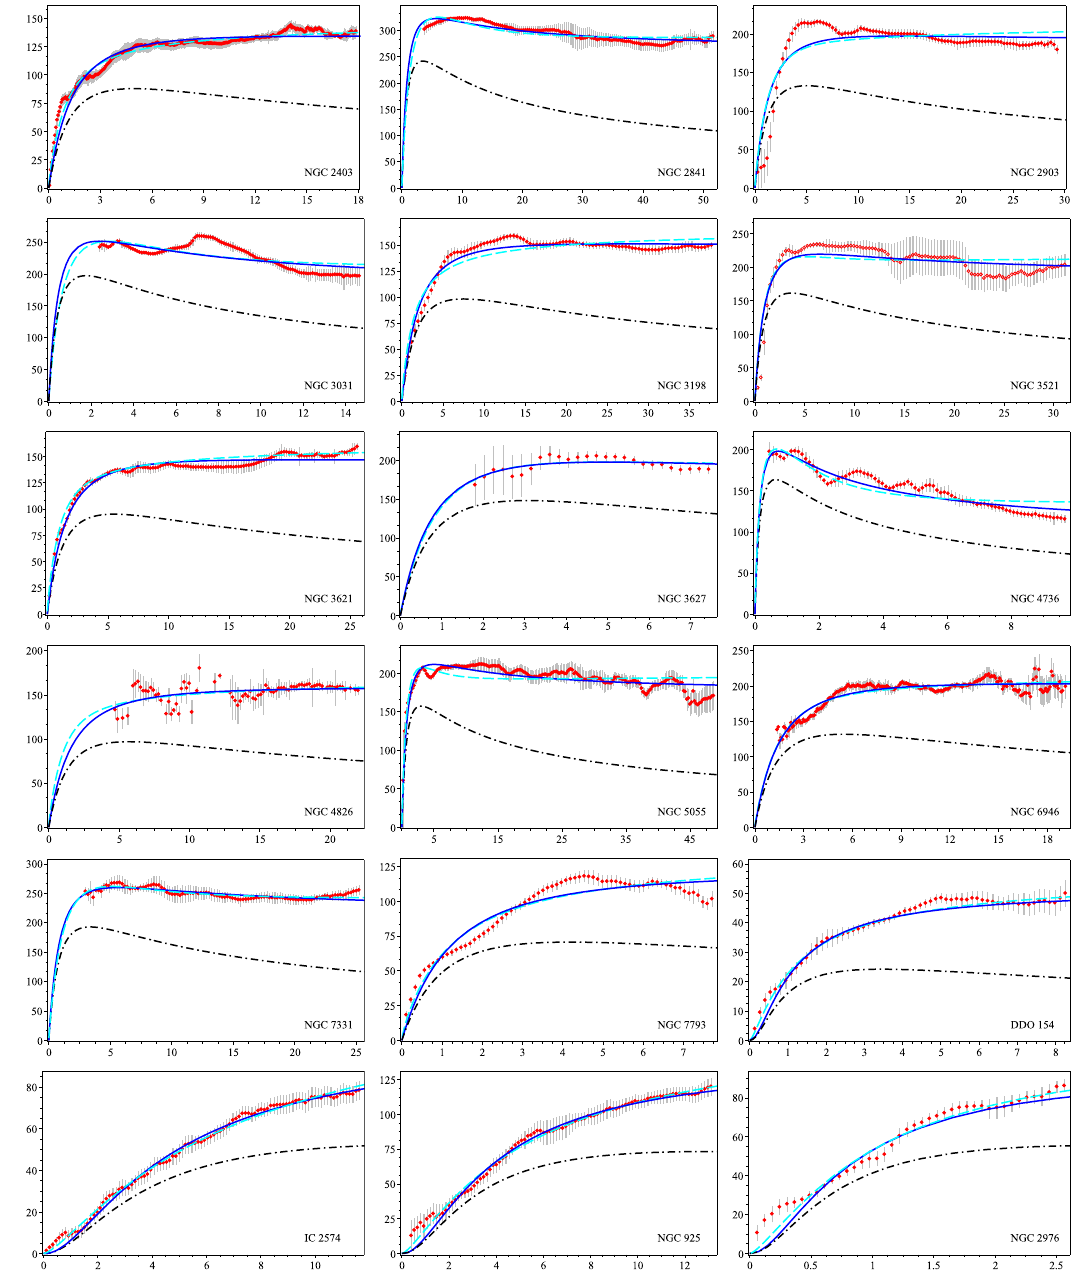
Figure 1. (color online) Rotational velocities in km/s ( y axis) at a certain distance in kpc ( x axis) from the center of the galaxy. The blue curves RC are obtained from the parametric fit of Equation (19) in the case of 18 THINGS galaxies. The proprieties of the galaxies in the sample can be found in Table I from Reference [55]. The full ( blue ) curve are the rotation curves obtained using Equation (19); the ( red ) full circles are the observed data points where the vertical ( grey ) lines represent the error bars; the contribution due to the Newtonian term is given by the dash-dotted ( black ) lines, while the dashed ( cyan ) lines give the MOND rotation curves. The numerical values resulted from the fits are given in Table